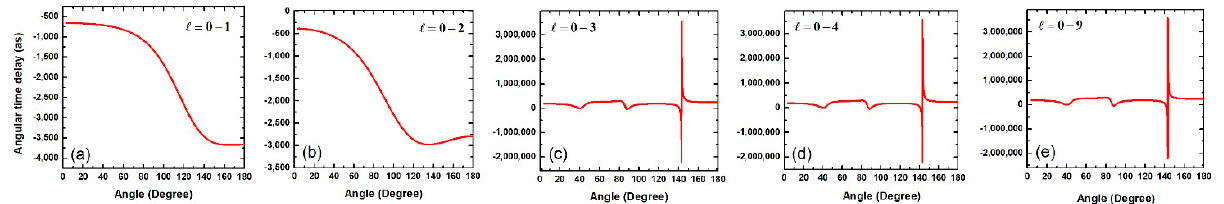
Figure 6. Angular time delay at the resonant energy E r = 0.0091 a.u. plotted for different partial wave combinations ( a ) 0 1 = combinations ( a ) (cid:96) = 0–1, ( b ) (cid:96) = 0–2, ( c ) (cid:96) = 0–3, ( d ) (cid:96) = 0–4 and ( e ) (cid:96) =